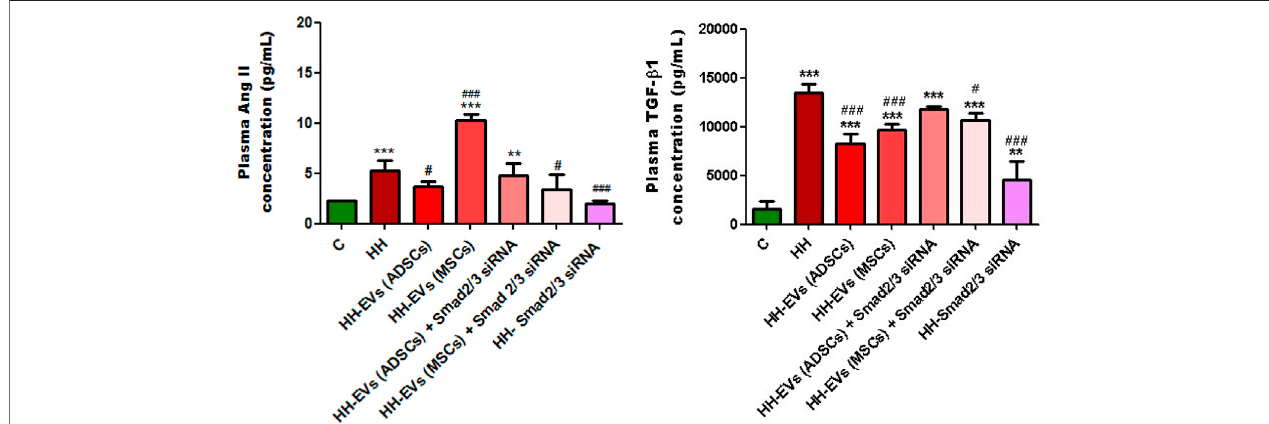
FIGURE 8 | Analysis of plasma TGF- β 1 and AngII levels by the enzyme-linked immunosorbent assay (ELISA) method, for all experimental groups: C, HH, HH- EVs(ADSCs), HH-EVs(MSCs), HH-EVs(ADSCs)+Smad2/3siRNA, HH-EVs(MSCs)+Smad2/3siRNA, and HH-Smad2/3siRNA. The measurements were performed in triplicate,and theresultsweredepictedasmean ±SD. Thestatisticalsigni fi cance, noticeablydifferent,wasrepresented as*** p < 0.005,** p < 0.01versuscontrolgroup and ### p < 0.005, # p < 0.05 versus HH group. The values were calculated by two-way ANOVA and Bonferroni post-test.